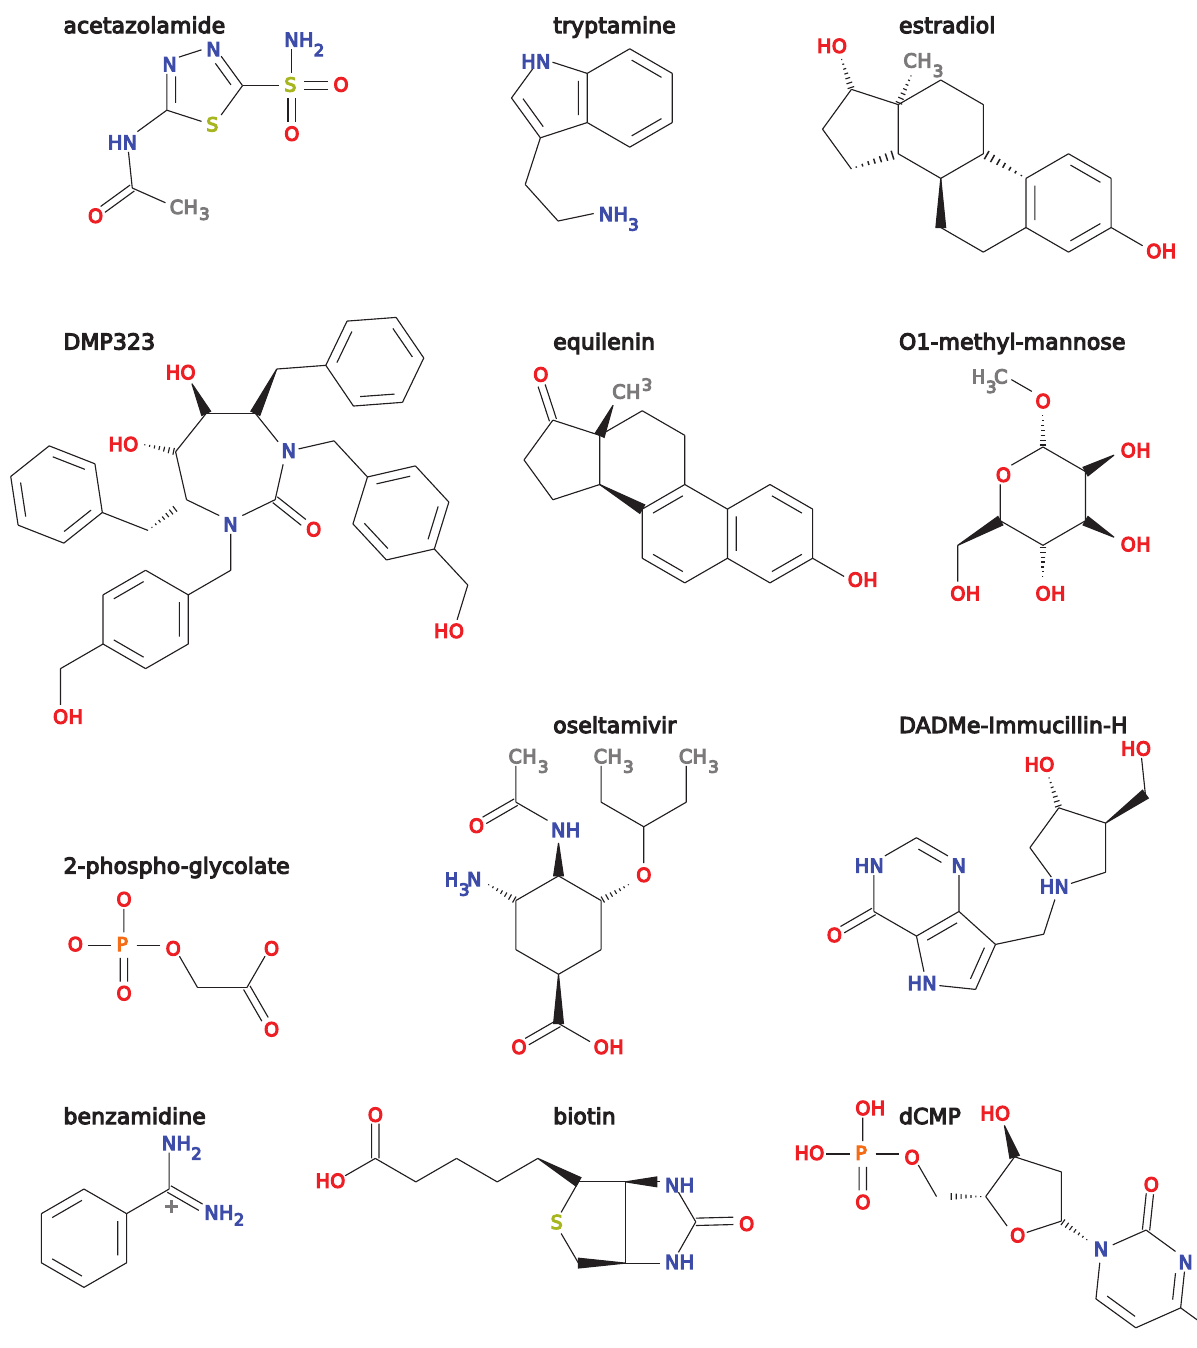
Figure 2. Two-dimensional structures of benchmark set ligands. The ligands of the test cases of our benchmark sets. See Table 1 for which ligand belongs to which test case.